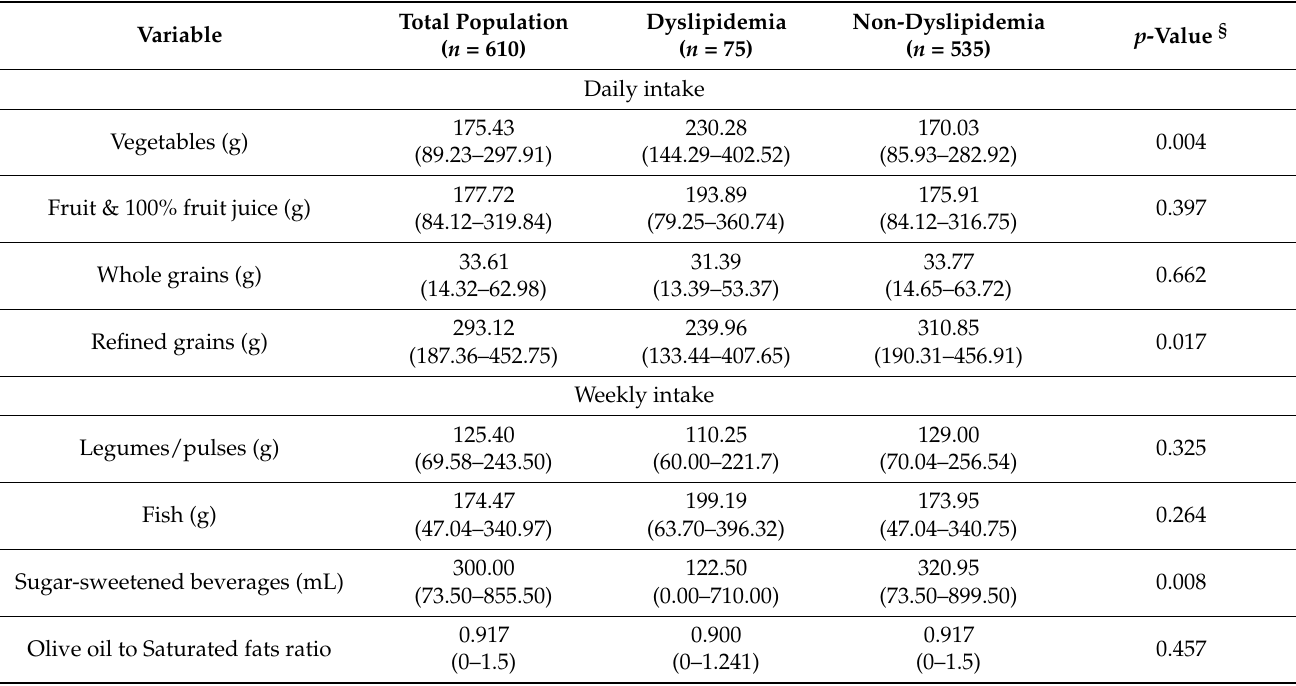
Table 5. c-MED Food group intakes of adults with and without